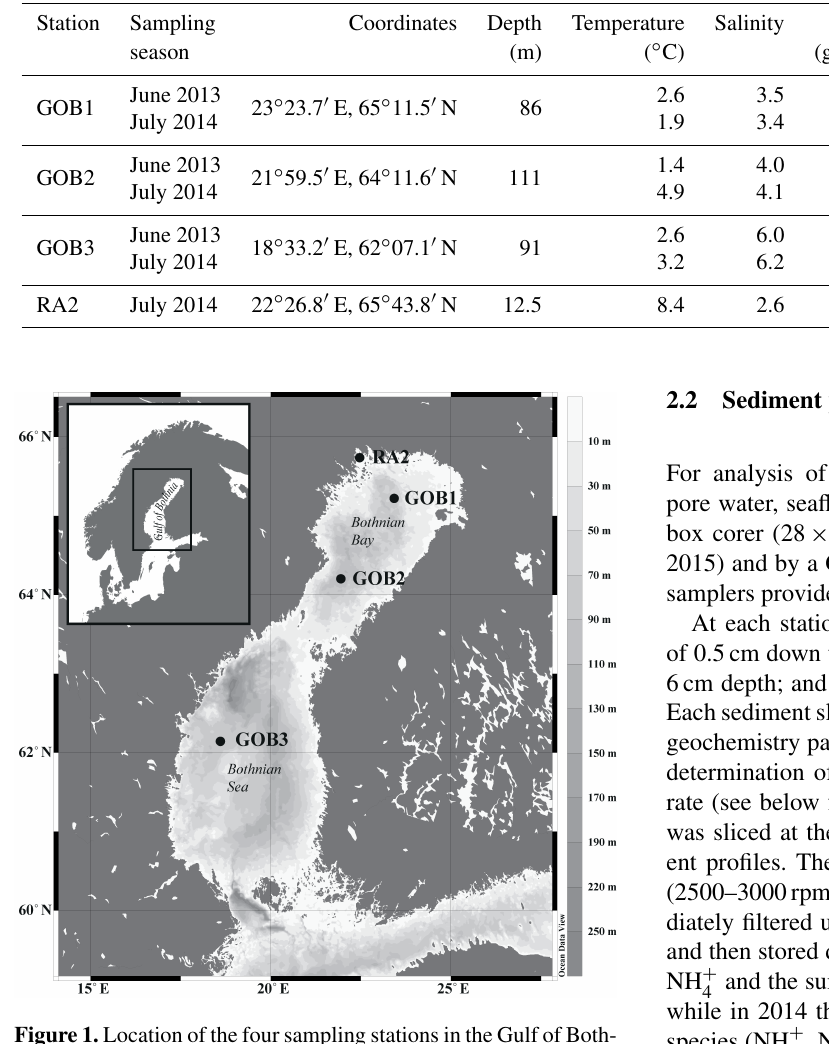
Figure 1. Location of the four sampling stations in the Gulf of Both- nia and bathymetry of its two sub-basins, the Bothnian Bay and the Bothnian